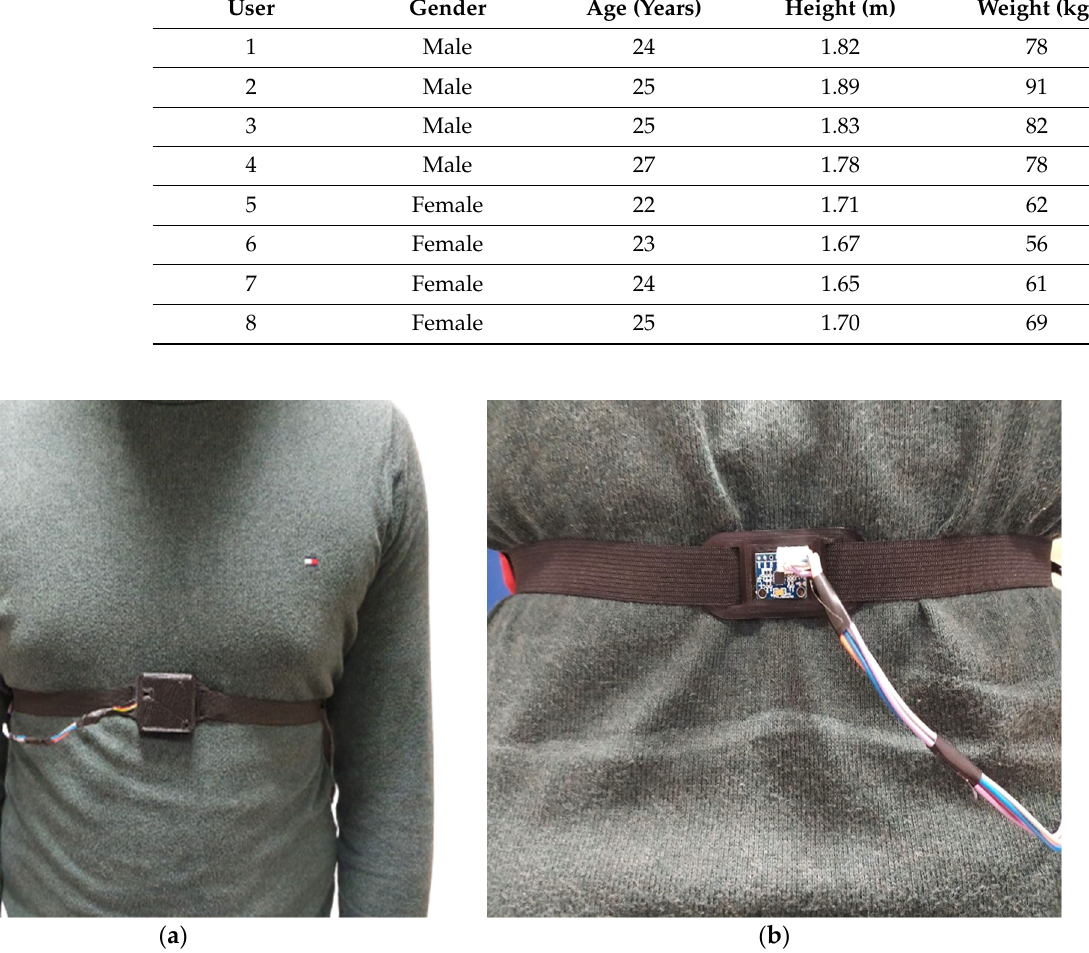
Figure 6. Front ( a ) and back ( b ) view of the inertia-based chest band for measuring respiratory rate.